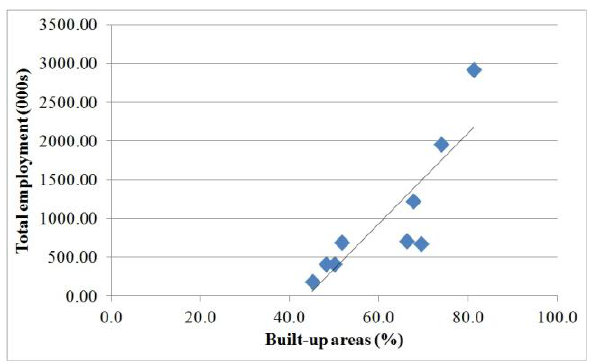
Figure 6. Relationship between the percentage of built-up areas and GDP for 2010 ( R 2 = 0.78)